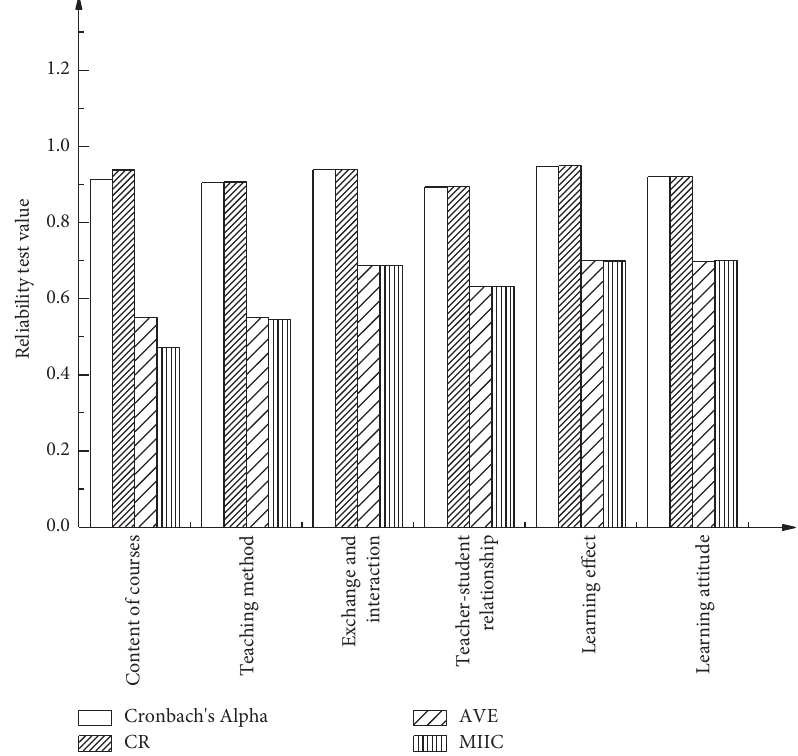
Figure 3: Reliability test of the MOOC online teaching for the quality evaluation